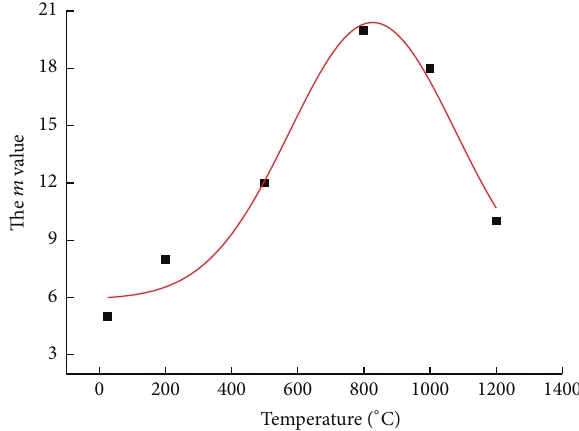
Figure 7: Variation of fractal dimension 𝐷 value with 𝑚 value at 25 ∘ C.